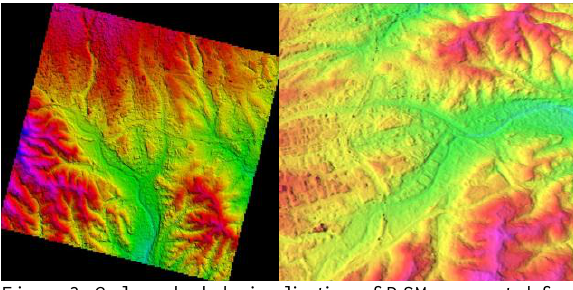
Figure 3. Colour-shaded visualization of DSM generated from Cartosat-1 stereo scenes over Terrassa area. Overview of the full model (left) and zoom on urban and open areas